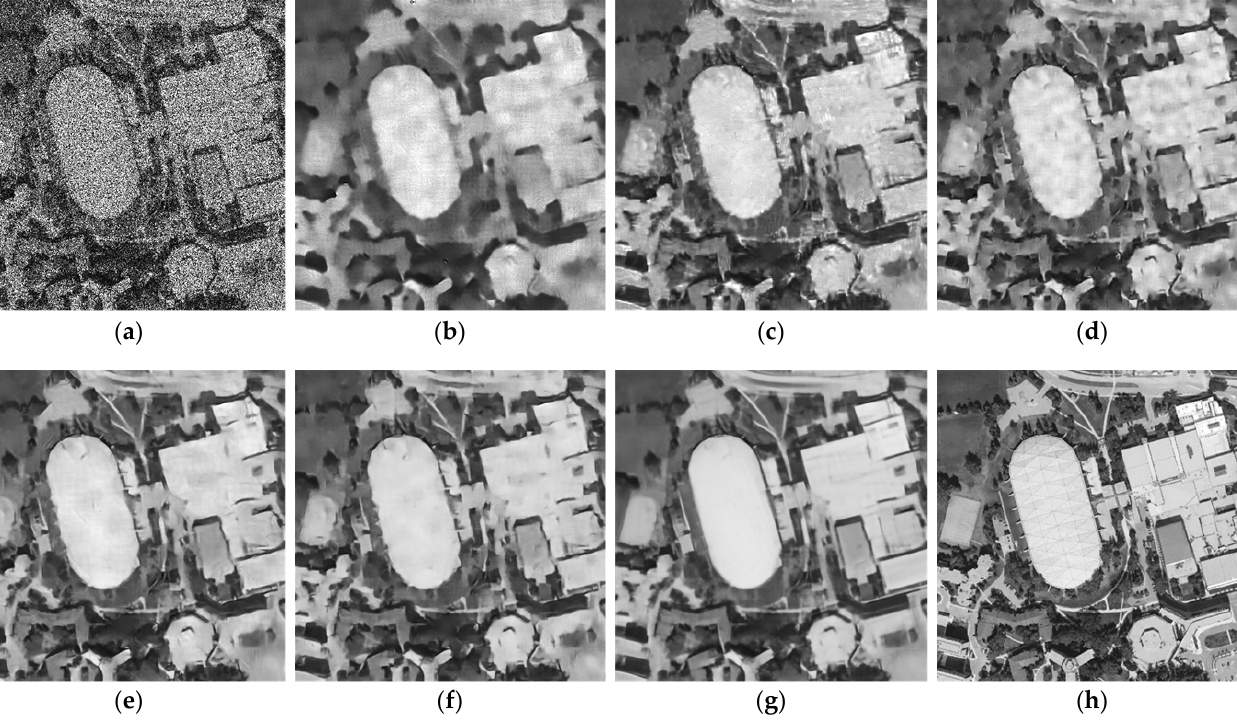
Figure 9. Despeckling results for the School image. ( a ) Speckled. ( b ) PPB. ( c ) SAR-BM3D. ( d ) ID-CNN. ( e )